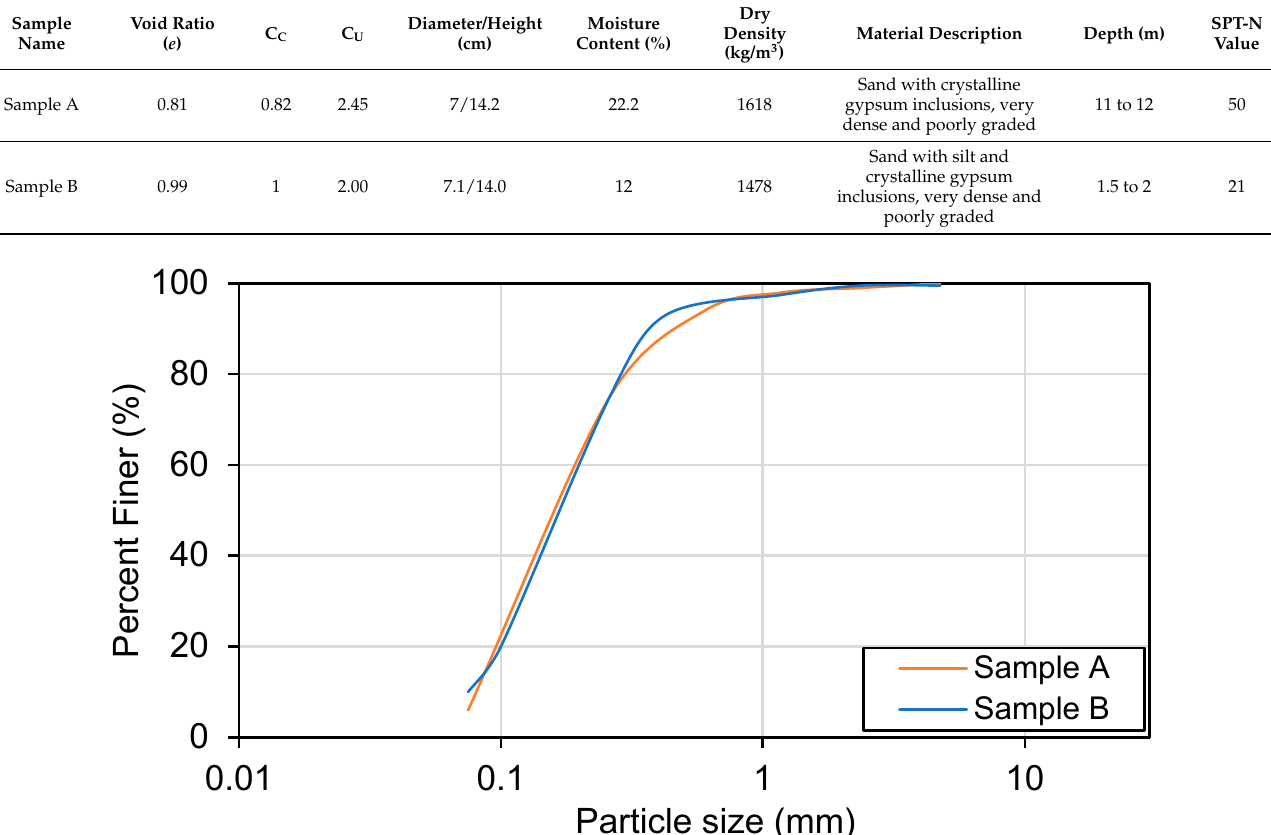
Figure 1. Particle size gradation of sands.